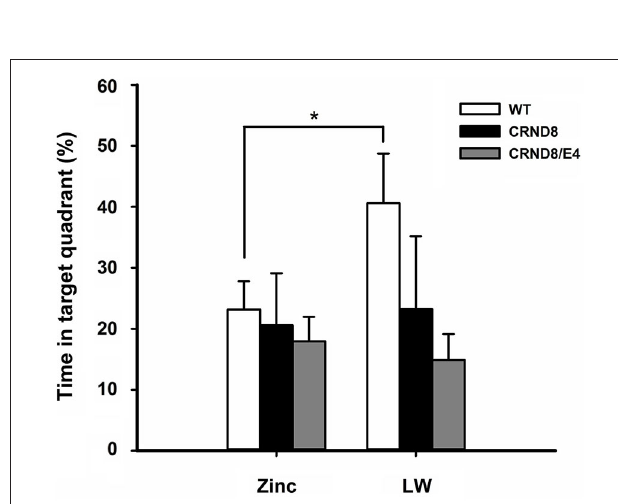
FIGURE 3 | Percent of time spent in the target quadrant in the Barnes maze. WT mice on Zn water spent significantly less time in the target quadrant during the 24-h probe trial when compared to lab water WT mice ( p < 0.05). Tg mice consistently scored at or below chance levels. Points are mean ± SEM. * denotes p <